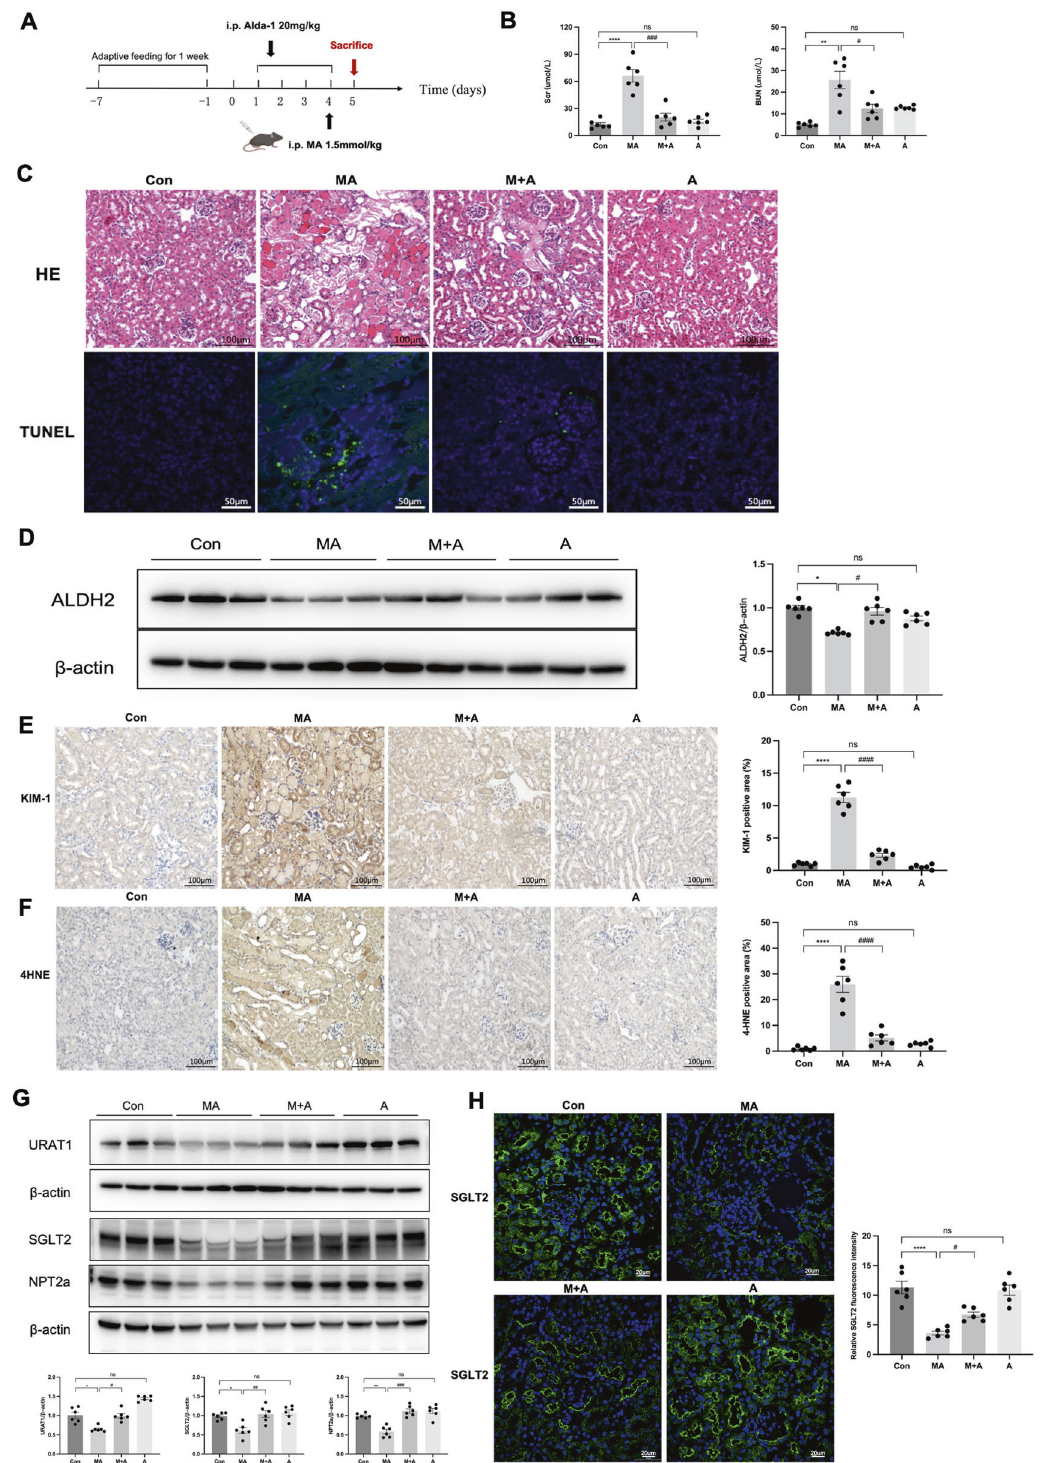
Fig. 3 ALDH2 activation alleviated renal injury in MA-induced AKI. A Mice were intraperitoneally (i.p.) injected with a single dose of maleic acid (MA) (1.5mmol/kg) and were sacri fi ced after 24h; Alda-1 (ALDH2 agonist, 20mg/kg) was injected by i.p. for 4 days. B Serum creatinine (Scr) and urea nitrogen (BUN) levels were measured in 4 groups ( n = 6). C Images of hematoxylin-eosin (HE) staining ( n = 6). Scale bars, 100 μ m; Terminal deoxynucleotidyl transferase – mediated dUTP nick end-labelling (TUNEL) assay were used to evaluate the tubular apoptosis ( n = 6). Scale bars, 50 μ m. D Western blotting and the quantitative analysis of ALDH2 ( n = 6). E , F Representative images of immunohistochemical staining of KIM-1 and 4HNE and quantitative analysis ( n = 6). G , H The expression of tubular transporter proteins (SGLT2, NPT2a and URAT1) was measured by western blotting ( n = 6) and immuno fl uorescence ( n = 6). Scale bars, 20 μ m. * P <0.05, ** P <0.01, *** P <0.001, **** P < 0.0001; # P <0.05, ## P <0.01, ### P <0.001, #### P <0.0001; ns not signi fi cant. (Con Control, MA maleic acid, M + A maleic acid + Alda-1, A Alda-1).